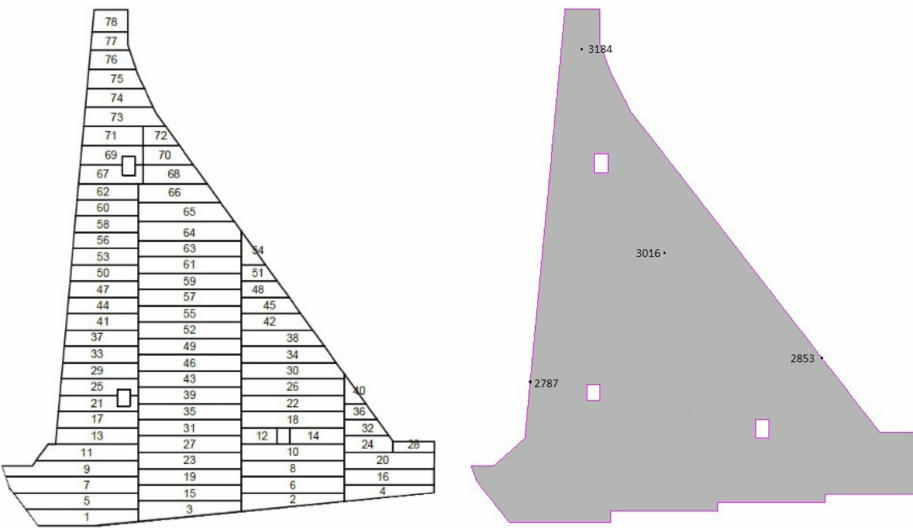
Figure 8. Distinctive control nodes of the model in the mid-plane of the monolith.